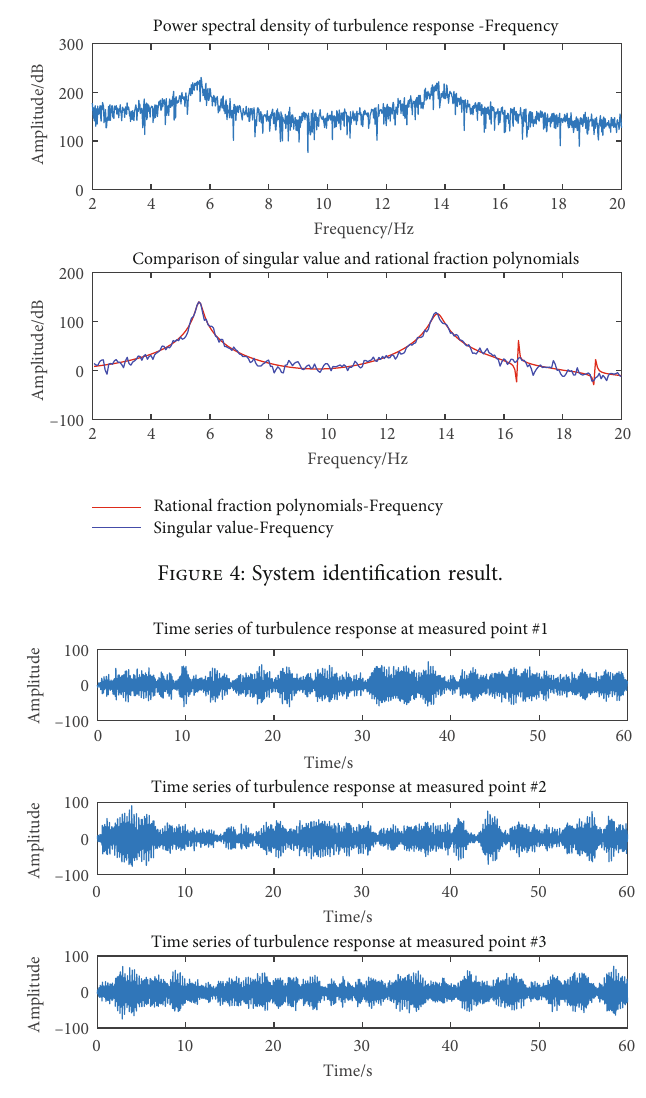
Figure 5: Time series of the two-mode turbulence response.